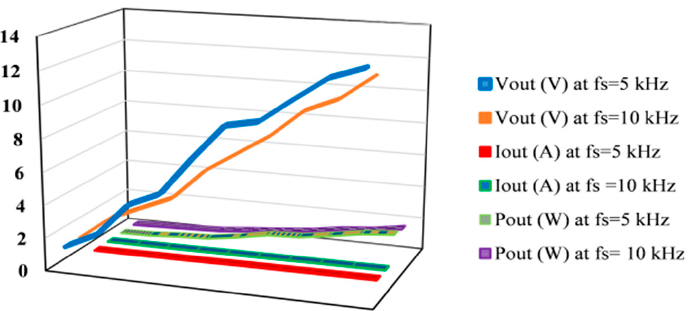
Figure 13. Output voltage, current and power comparison at switching frequencies f s = 5 kHz and f s = 10 kHz. Table 13. Inductor voltage, current and power loss at f s = 5 kHz and D = 50%.